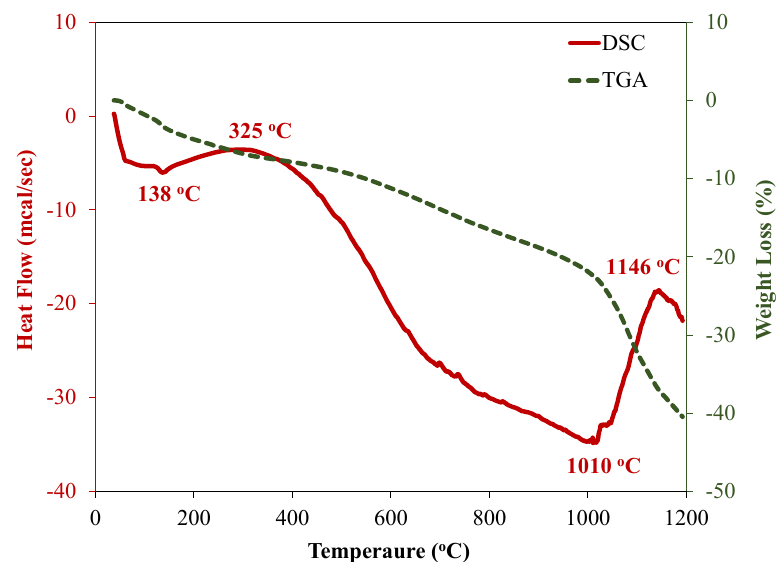
Figure 8. Thermal analysis of recycled rubber waste.